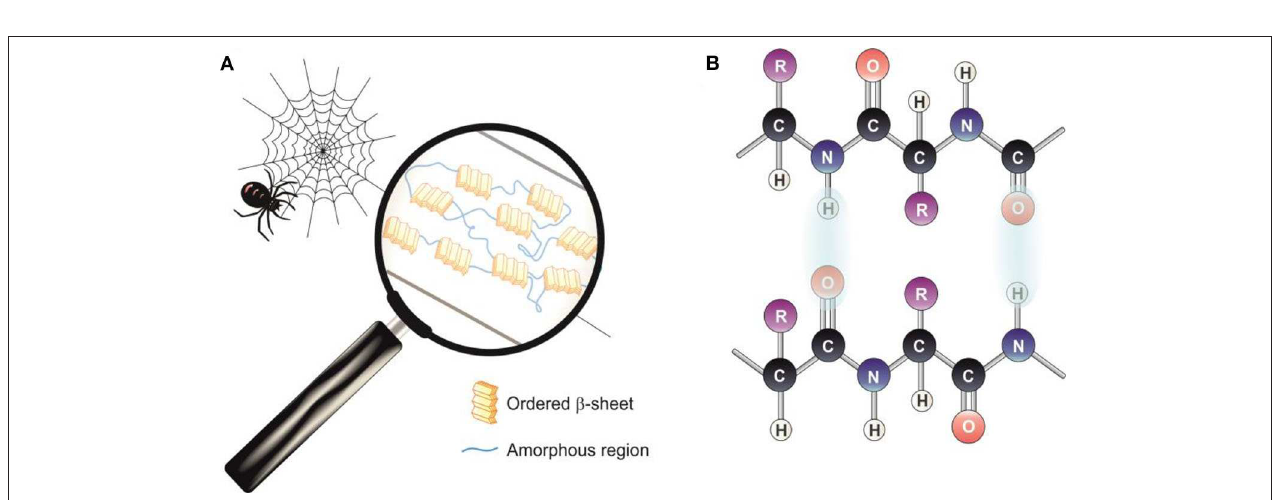
FIGURE 4 | (A) Schematic structure of spider silk. The yellow blocks are the highly ordered crystalline regions, joined by amorphous linkages. (B) Hydrogen bonds between parallel protein chains.